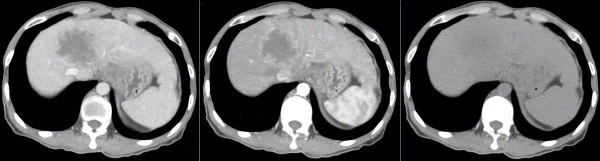
Three phases of CTs for the same patient. Left: portal venous phase (PVP) CT; Middle: hepatic arterial phase (HAP) CT; Right: non-enhanced CT.